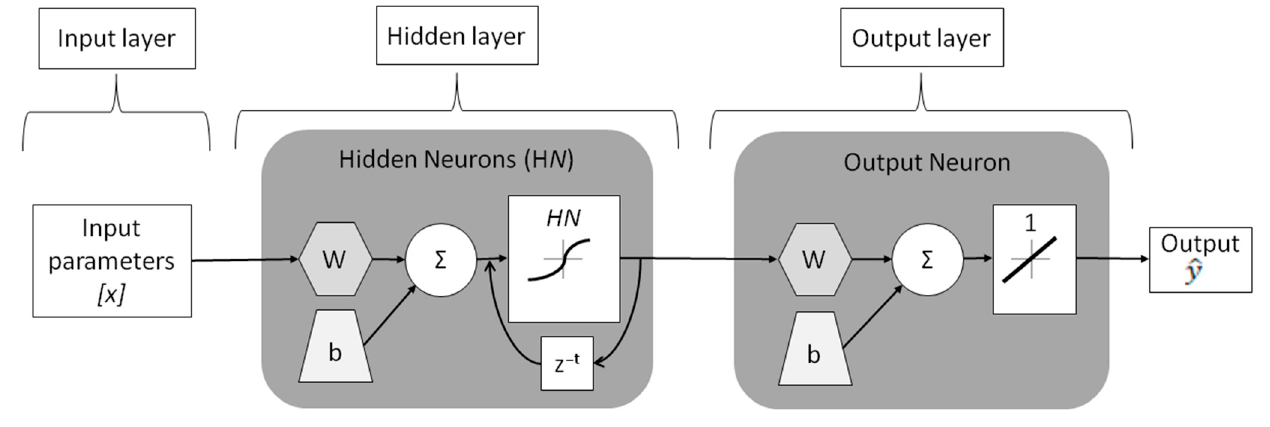
Figure 2. RNN forecaster’s layout.